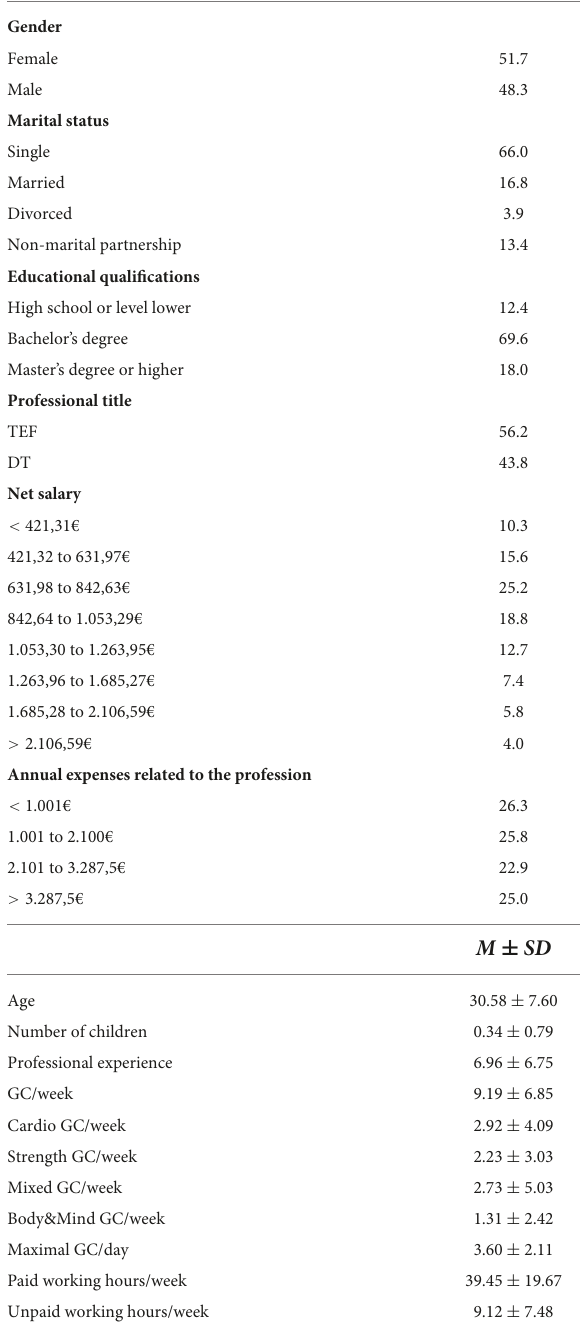
TABLE 1 Descriptive statistics of the variables.